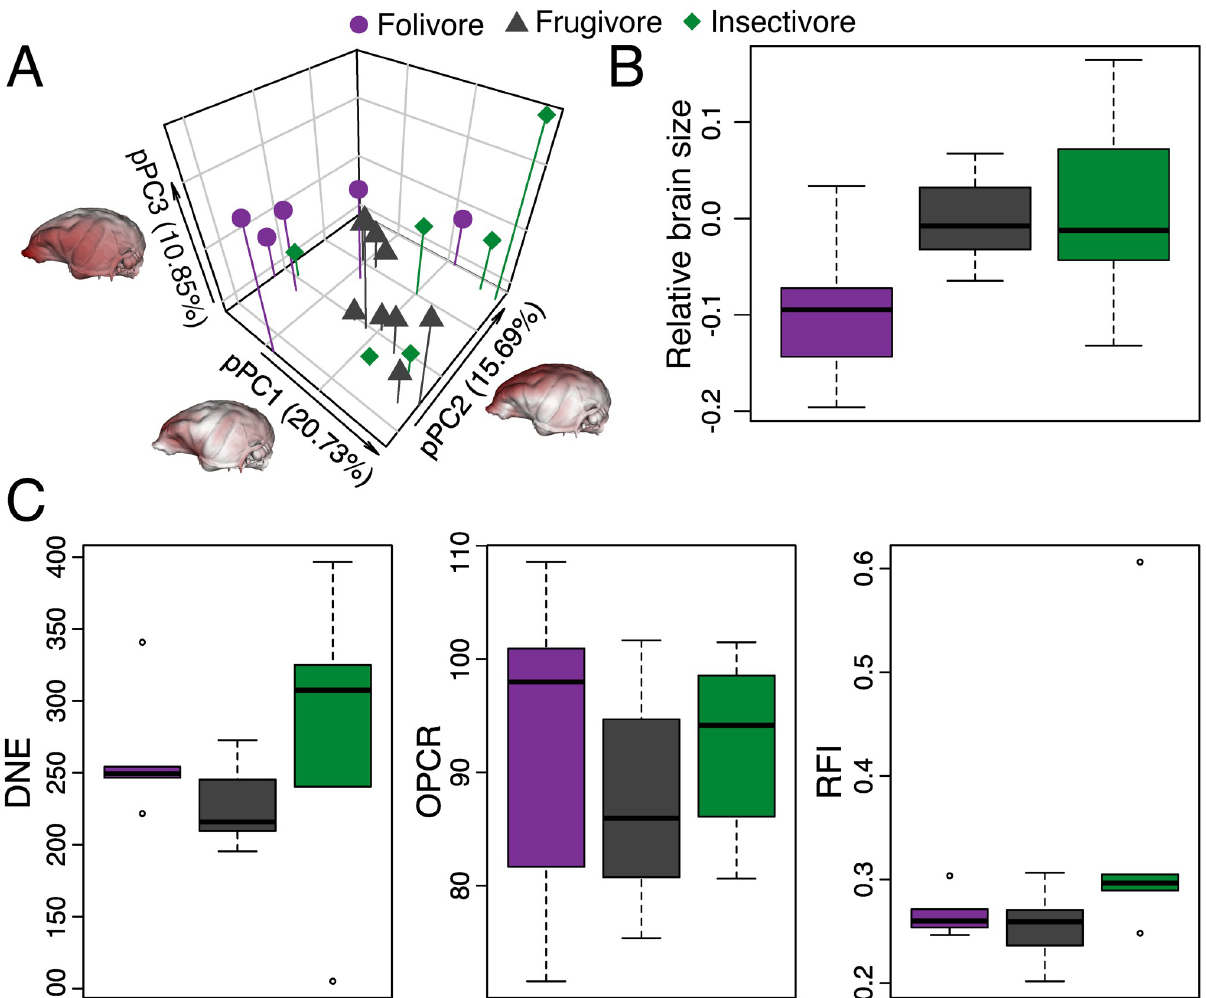
Fig 1. Patterns of strepsirrhine phenotypic variation across dietary guilds. Phylomorphospace of allometry-controlled brain shape based on the phylogenetic principal component analysis (A); boxplots of allometry-controlled centroid size (relative brain size) across dietary guilds (C); boxplots of dental morphological variation across dietary guilds (C), representing Dirichlet Normal Energy (DNE; bottom left), Orientation Patch Count Rotated (OPCR; bottom middle) and Relief Index (RFI; bottom right). Endocast heatmaps exemplify differences in brain shape between species occupying opposite ends of each principal component. Heatmaps were obtained by warping the endocast of the modern taxon closest to the inferred average morphology ( Eulemur fulvus ) based on the Procrustes coordinates of species on opposite ends of a principal component and estimating the distance between